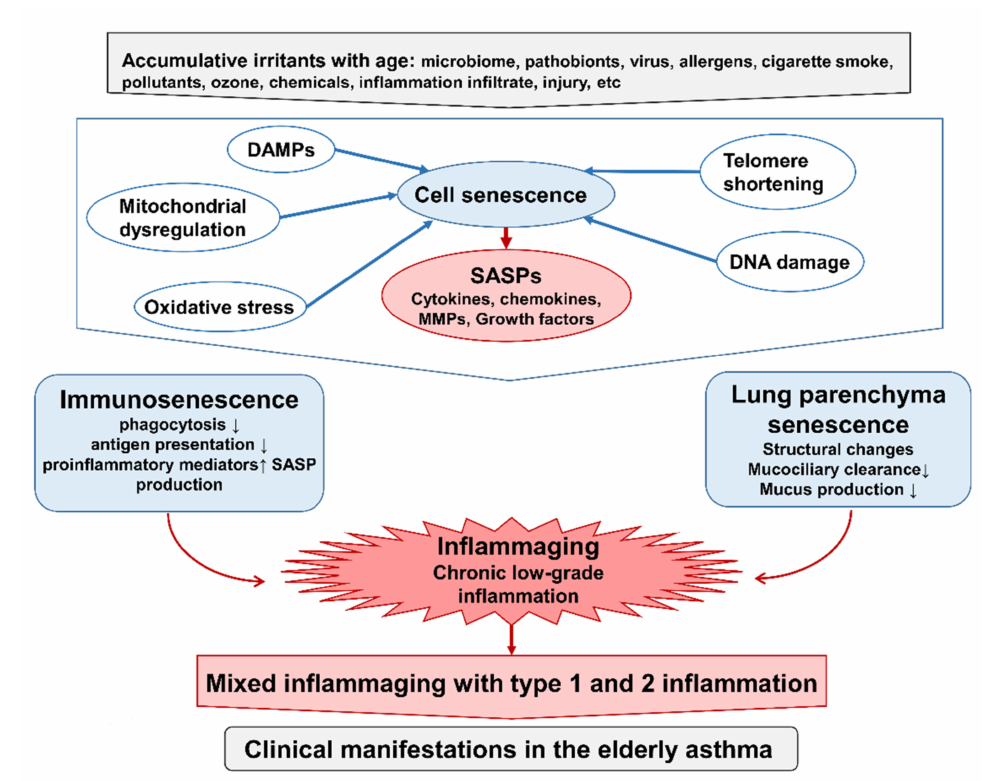
Figure 1. Concept of integrated inflammaging type-2 inflammation in asthma in the elderly. Diverse extrinsic and intrinsic stresses can upregulate various pathways and subsequently activate immune cells and airway epithelial cells or damage these cells. Induction of immune cells senescence, mito- chondrial dysregulation, oxidative stress, and damage-associated molecular patterns (DAMPs) in response to these stresses contribute to immunosenescence, accompanied with lung parenchyma senescence. Cell senescence is also initiated by the immune response and produces the senescence- associated secretory phenotypes (SASPs), which lead to immunosenescence progression. Age-related alterations in the immune system promote inflammaging, which is influenced by lung parenchyma aging. Inflammaging may modify type-2 inflammation and promote mixed inflammation with type-1 and -2 immune response in elderly patients with asthma, leading to specific clinical